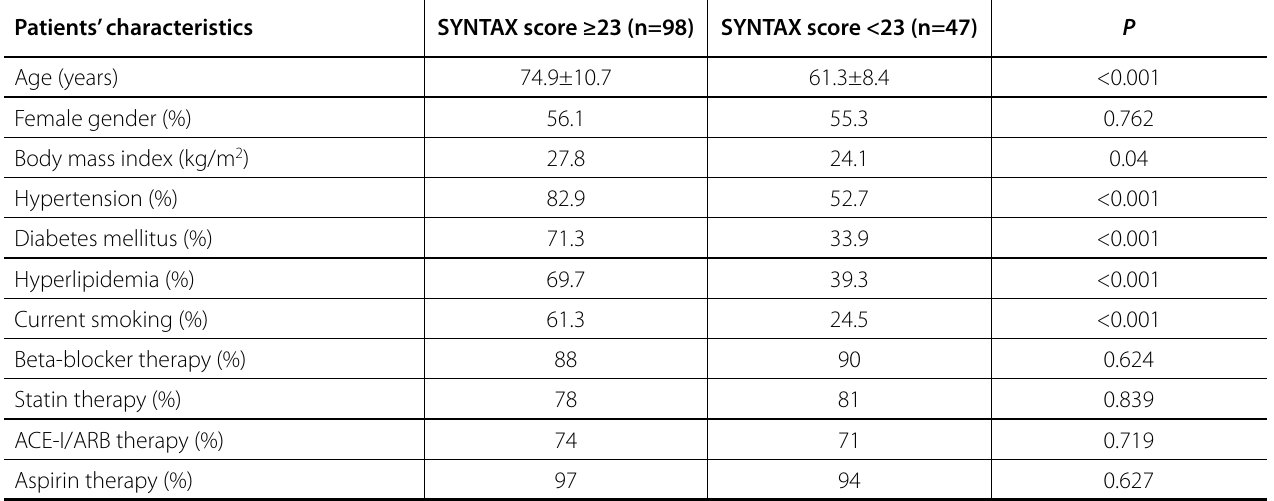
Table 1. Patients’ characteristics.